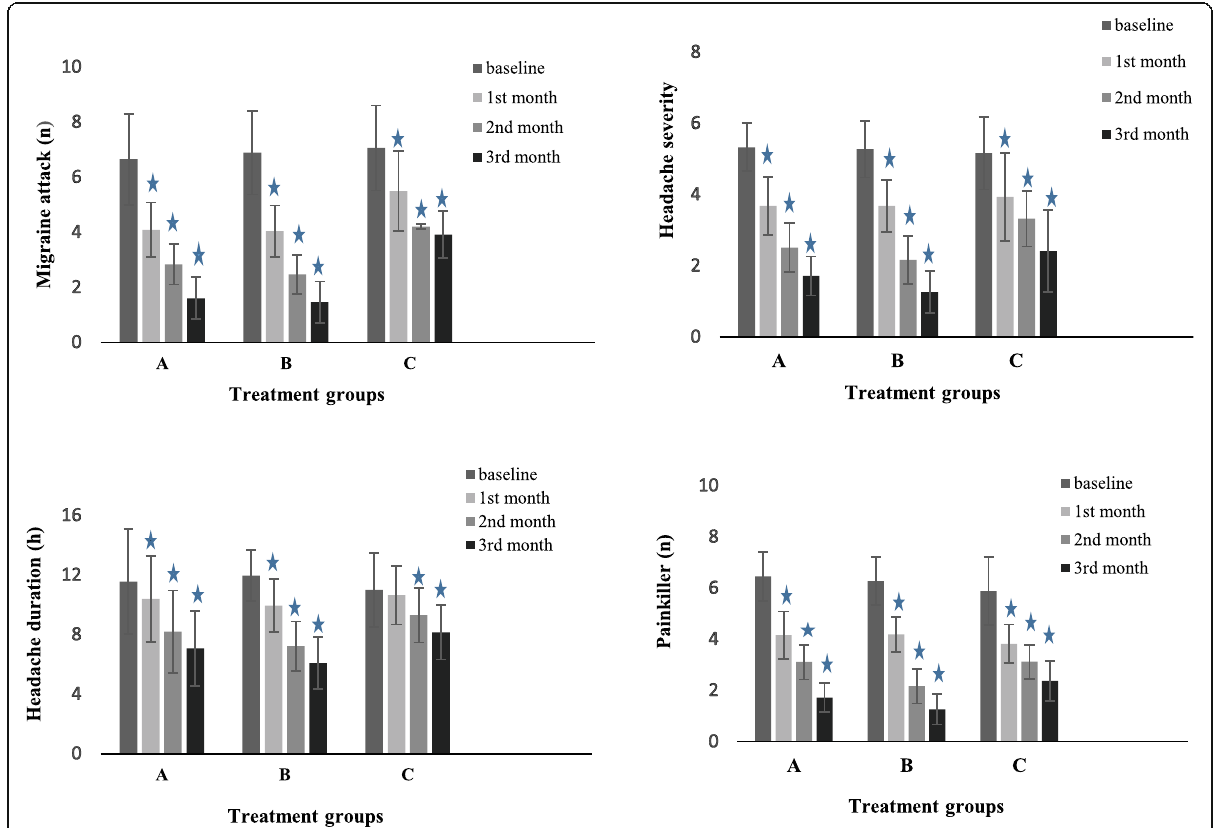
Fig. 2 Migraine characteristics of the three groups in different treatment periods; * P values ≤ 0.05 were considered statistically significant vs baseline [measured using sample (paired) t test]. A: Sodium Valproate; B: Sodium Valproate +Magnesium; C: